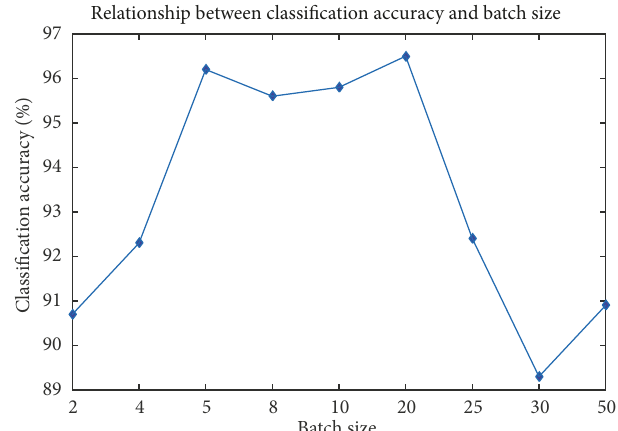
Figure 11: Relationship between classification accuracy and batch